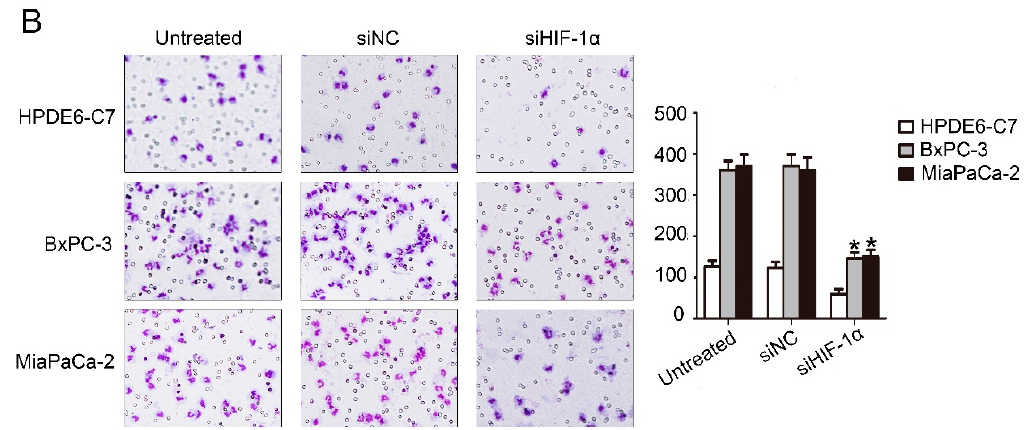
Figure 4. HIF-1 α promoted the recruitment of macrophages. ( A ) A comparison of the ability of recruiting macrophages by HPDE6-C7, BxPC3, and MiaPaCa-2 cells transfected with pcDNA3.1 and pcDNA3.1-HIF-1 α plasmids (4 µg) for 48 h using Boyden chambers. The experiments were performed